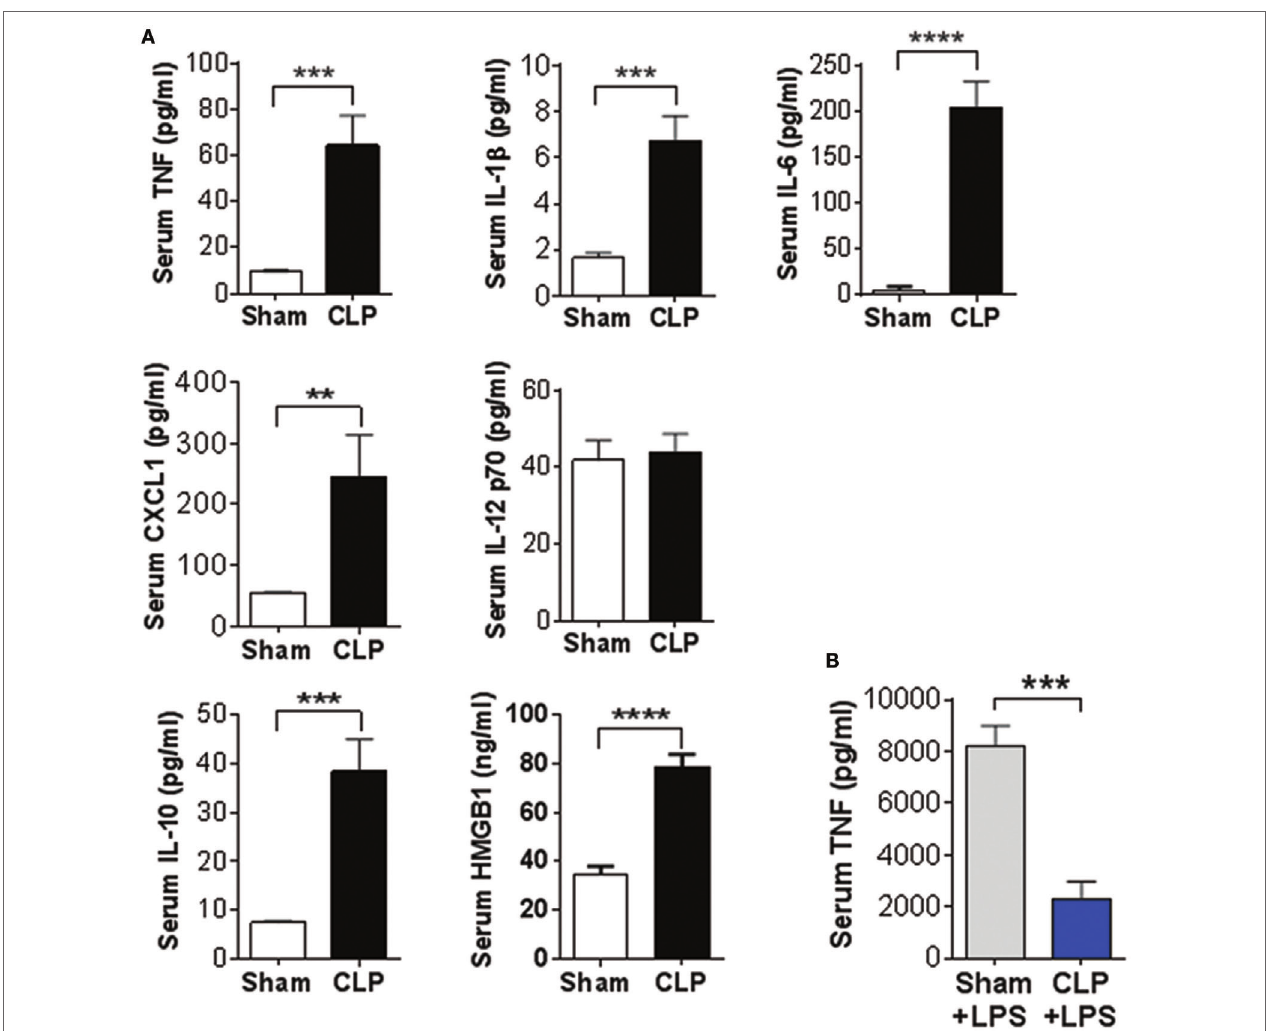
FigUre 2 | Cecal ligation and puncture (CLP)-sepsis alters circulating cytokine levels and suppresses LPS-induced immune responsiveness. (a) Increased serum cytokine levels in mouse sepsis survivors 14 days after CLP or sham surgery. ** P = 0.0092, *** P = 0.0004 (TNF), *** P = 0.0002 (IL-1b, IL-10), **** P = 0.0001, Student’s t -test, n = 7–9 per group. (B) Sepsis survivors exhibit reduced LPS-induced serum TNF levels during endotoxemia when compared to sham controls. *** P = 0.001, Student’s t -test, n = 8–9 per